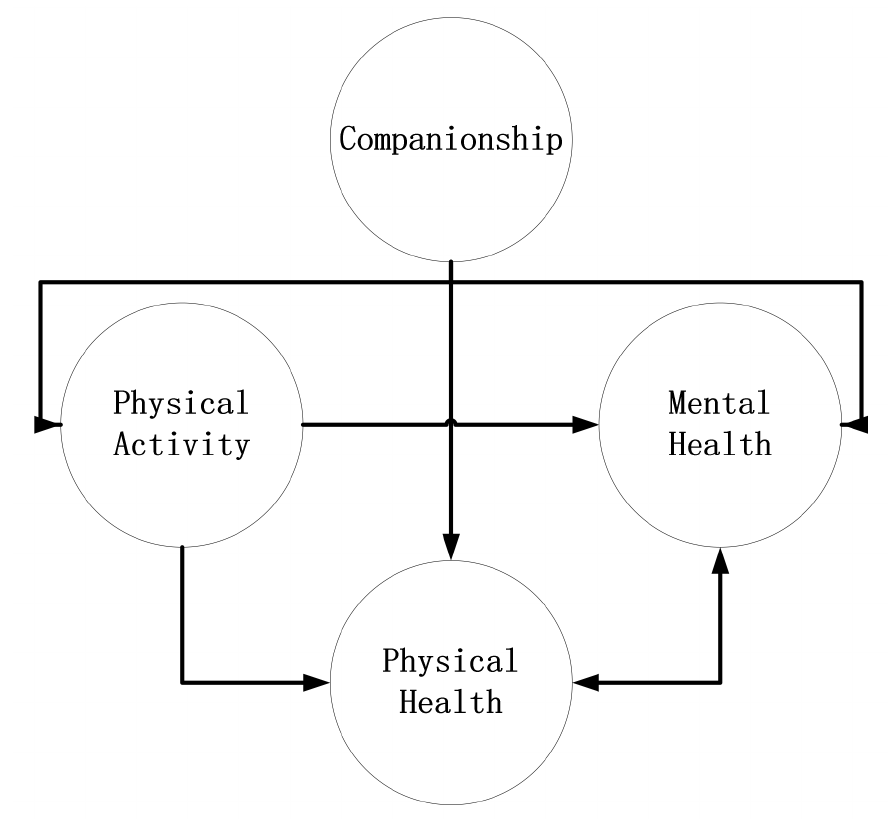
Figure 1. Conceptual model with hypothesized